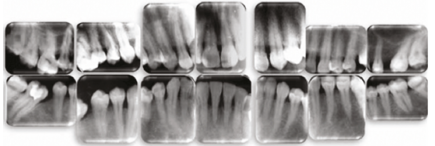
Figure 8: Final periapical radiographs 2 years post